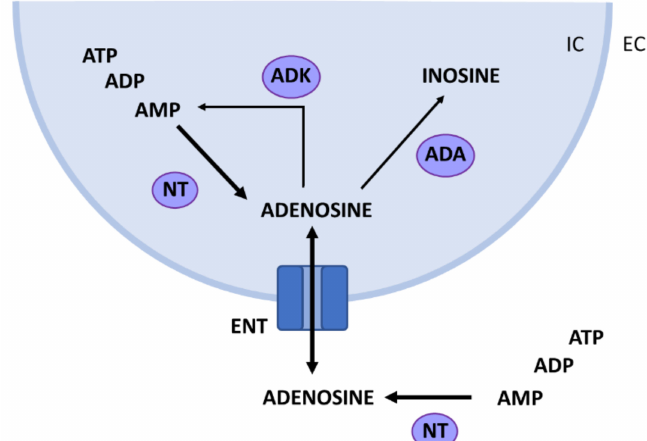
Figure 1. Adenosine metabolism in the brain: intra-(IC) and extracellular (EC) catabolization of adenine nucleotides (ATP, ADP, AMP) by nucleotidases (NT) leads to formation of adenosine. Intracellularly, adenosine deaminase (ADA) breaks down adenosine to inosine and adenosine kinase (ADK) phosphorylates adenosine to AMP. Bidirectional transport of adenosine via equilibrative nucleoside transporters (ENT) equalizes the IC and EC adenosine